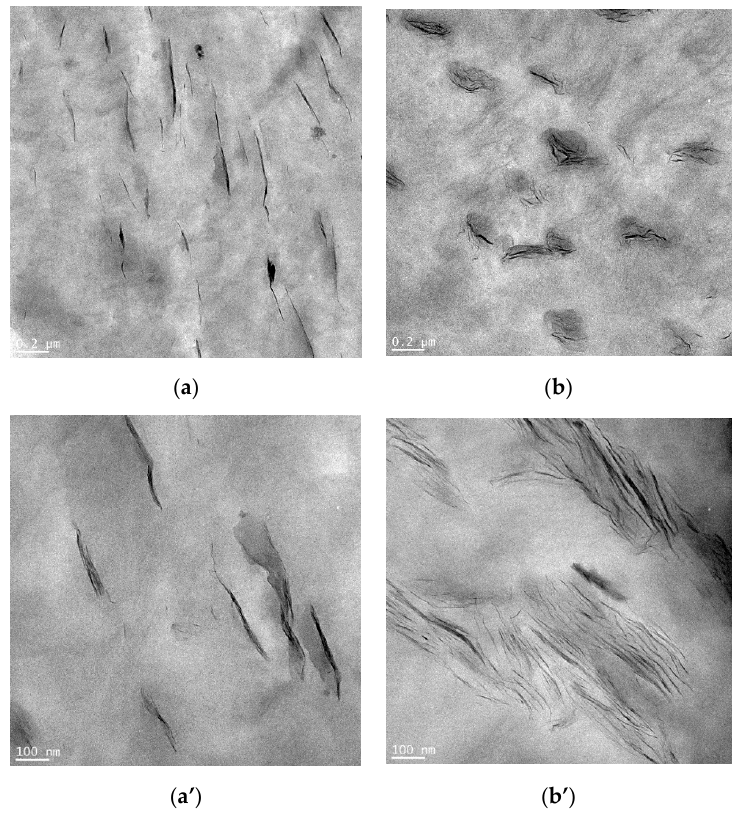
Figure 2. Low and high magnification TEM micrographs for ( a , a’ ) specimen #4 and ( b , b’ ) specimen